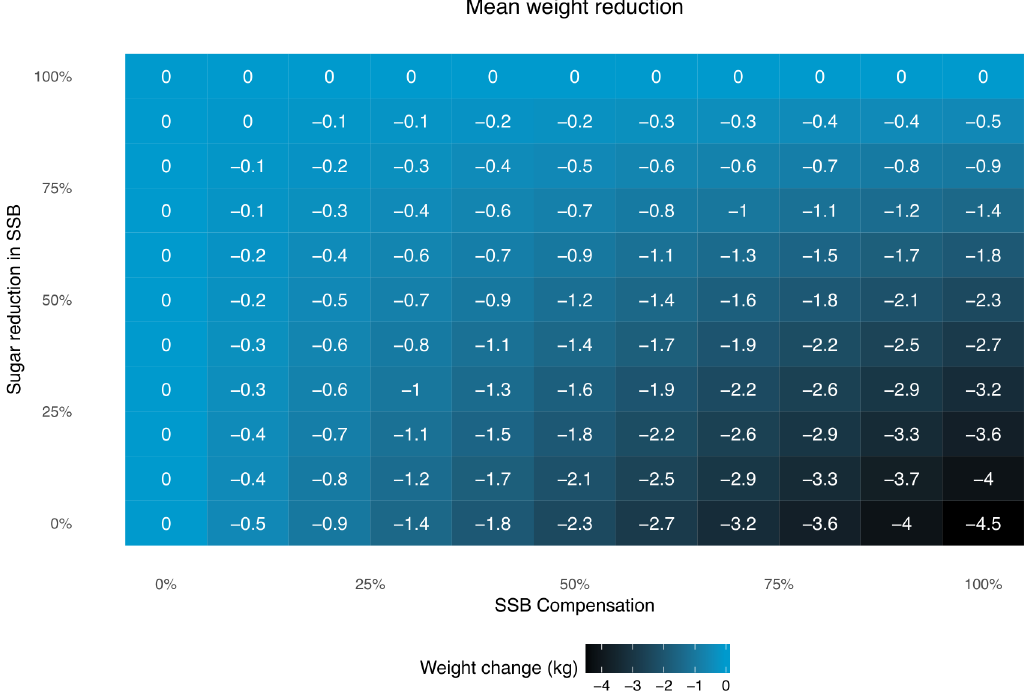
Fig 1. Sensitivity analysis for estimated weight change after 12 years proposing different sugar reductions and different compensation rates. SSB, sugar-sweetened